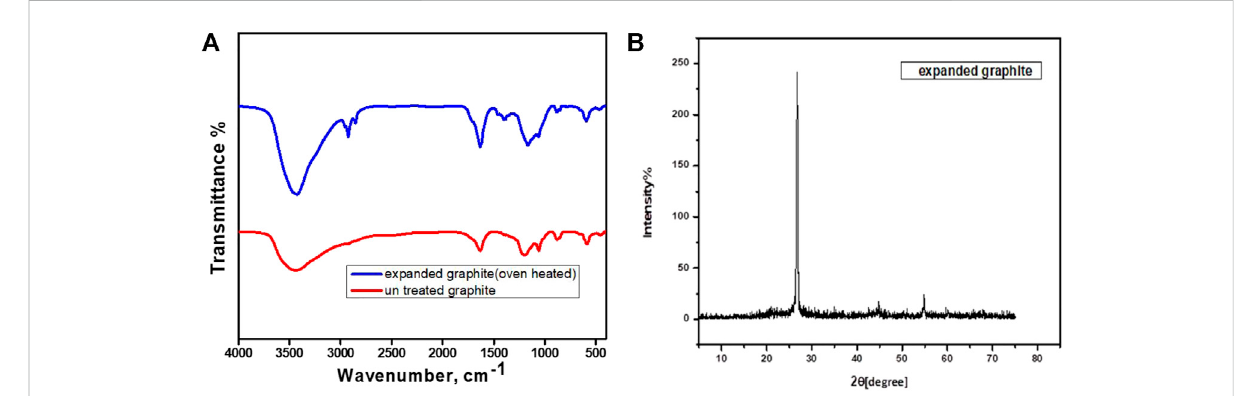
FIGURE 2 (A) FTIR of pristine graphite and expanded graphite. (B) XRD graph of GO (graphite